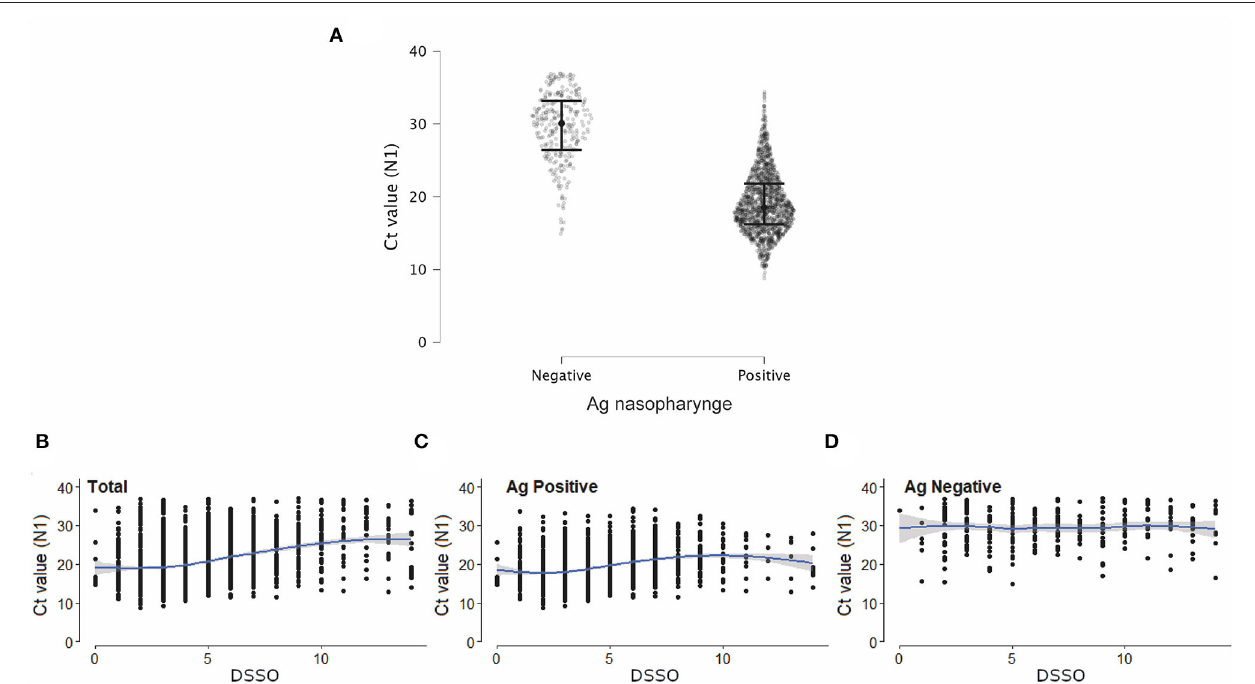
FIGURE 3 | Discordant samples (RT-PCR + /Ag-RDT-) showed higher C t values than concordant ones (RT-PCR + /Ag-RDT + ). (A) C t values (N1 target) of SARS-CoV-2 RT-PCR in patients with a positive ( n = 1,539) or negative ( n = 293) nasopharyngeal antigen (Ag) rapid diagnostic test (RDT) result tested from August 2020 to September 2021. (B–D) Correlation between C t value (N1 target) of SARS-CoV-2 RT-PCR and days since symptom onset (DSSO) when samples were collected in total patients (B) , and among patients with a positive or negative Ag-RDT result ( C,D ,